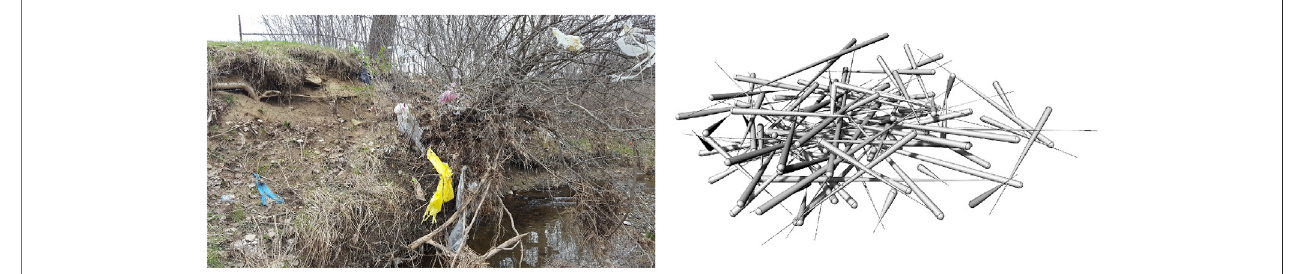
FIGURE 11 | Erosion prevention concept for engineering structures — A typical exposed root system along a riverbank catching plastic debris (left) can be one of several functions of an abstracted root structure (right) that could replace the ends of bridge abutments or the edges of culverts to reduce erosion and scour.